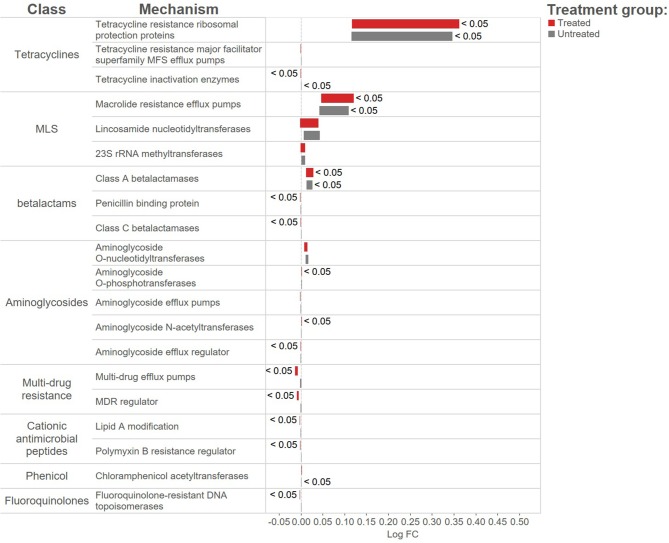
Log-fold change in abundance to AMR mechanisms for the treated (red bars) and untreated (gray bars) over time from Day 1 to day11. Bars to the right of the 0-line signify an increase in abundance, the size of the bars represent the average expression of the AMR mechanism and bars are labeled with adjusted p-values < 0.05.